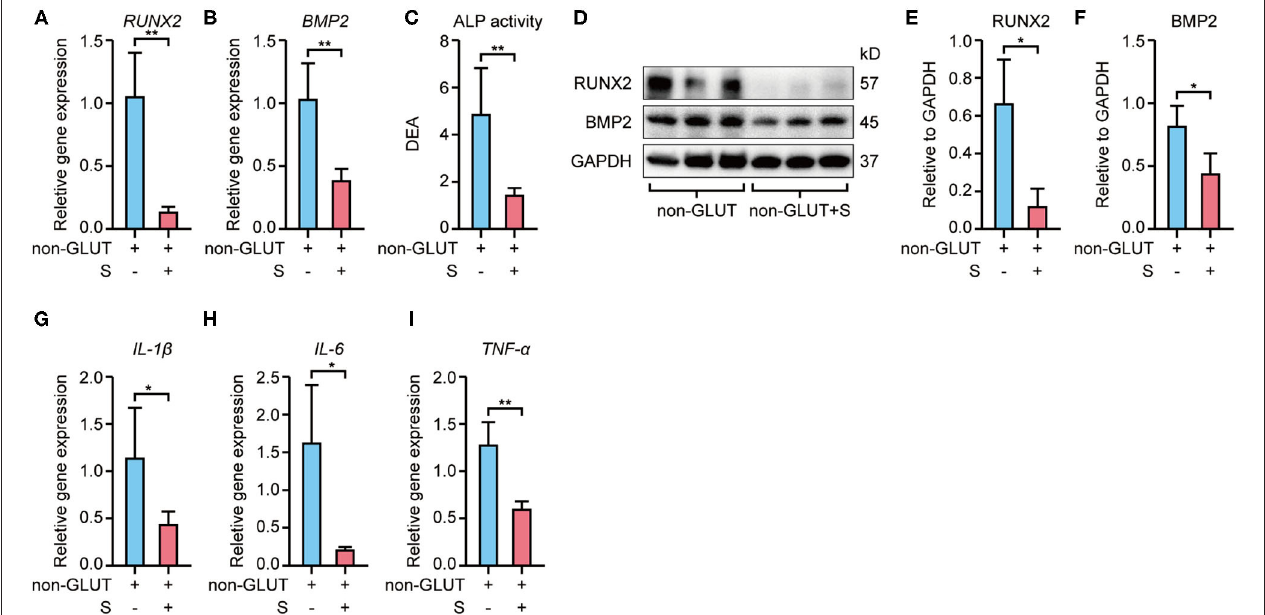
FIGURE 3 | Expression of osteoblast and inflammatory markers of non-GLUT BHVs in implant and implant + S groups 56 days after implantation. (A,B) Sevelamer reduces Runx2 and Bmp2 mRNA levels. (C) Sevelamer reduces ALP activity. (D–F) Protein expression of RUNX2 and BMP2 quantification analysis (E,F) and representative blotting (D) . (G–I) mRNA expression of IL-1 β (G) , IL-6 (H) , and TNF- α (I) decreased in the implant + S group. N = 3 for Western blot, N = 4 for RT-qPCR, N = 5 for ALP activity. non-GLUT represents non-GLUT BHVs in the implant group, and non-GLUT + S represents non-GLUT BHVs in the implant + S group. Data are mean ± SD, * p < 0.05, ** p <